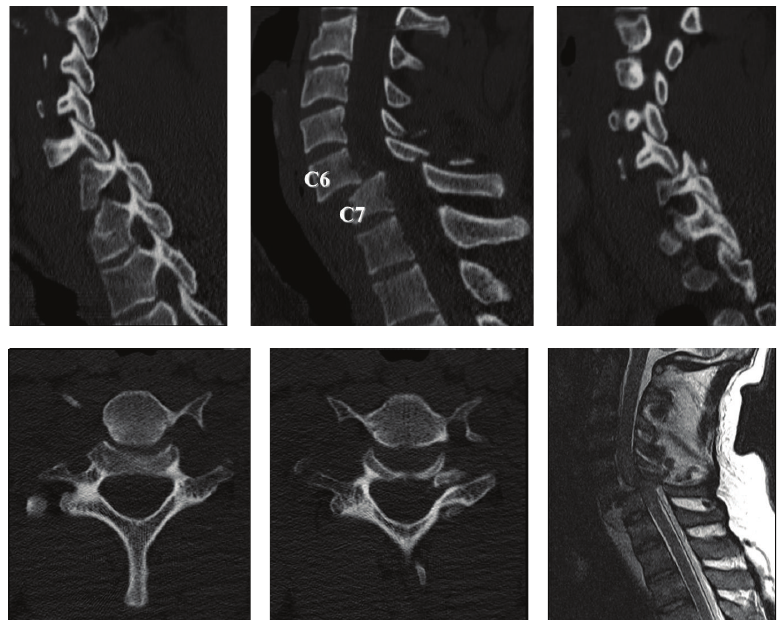
Figure 1: CT cervical scan showing a severe retrolisthesis of C6 on C5, with facet joint dislocation. MRI confirming the listhesis and demonstrating severe spinal cord injury with signs of